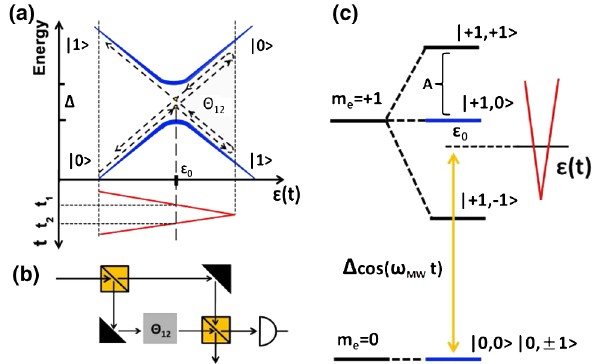
FIG. 1. Scheme for realizing a LZS interferometer on a single spin of the NV center in diamond. (a) Energy diagram of a two- level LZS interferometer: starting at j 0 i , the system is driven through the avoided level crossing (at t 1 ) and splits into a superposition of j 0 i and j 1 i via LZ tunneling. After accumulating a relative phase (cid:4) 12 , the system evolves back to the avoided level crossing (at t 2 ) where quantum interference occurs. (b) A MZ interferometer can be used to describe the LZS interferometer, with LZ tunneling acting as an optical beam splitter. (c) Realization of the LZ Hamiltonian in a NV center: the two-level system of the LZS interferometer is expanded in ¼ 0 and m ¼ þ 1 with the 14 N nuclear electronic spin states m e e ¼ 0 state, respectively, (blue lines). A selective spin in the m I microwave field with frequency ! MW (yellow double arrow) and with strength (cid:1) can act as the minimum energy separation after going into the rotating frame; " 0 in the LZ problem can be tuned directly by the microwave frequency. The driving field " ð t Þ (red folded lines) is applied along the [111] crystal transition j 0 i $ j 1 i when (cid:1) (cid:3) A . In the rotating frame